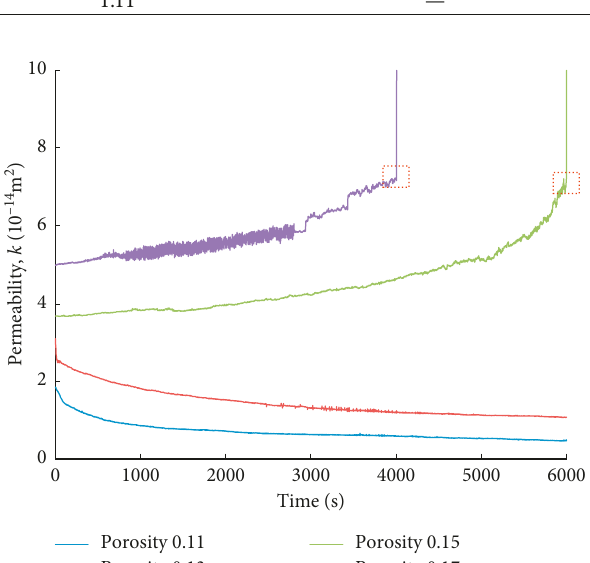
Figure 7: Permeability-time curves of tested specimens cemented by gypsum (the red rectangles mark seepage instability).